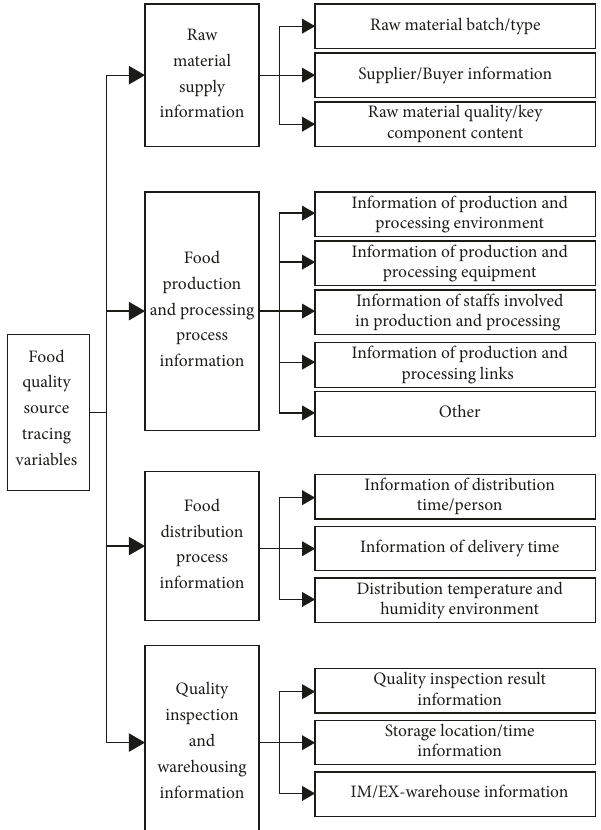
Figure 2: Summary of food quality and safety source tracing variables.